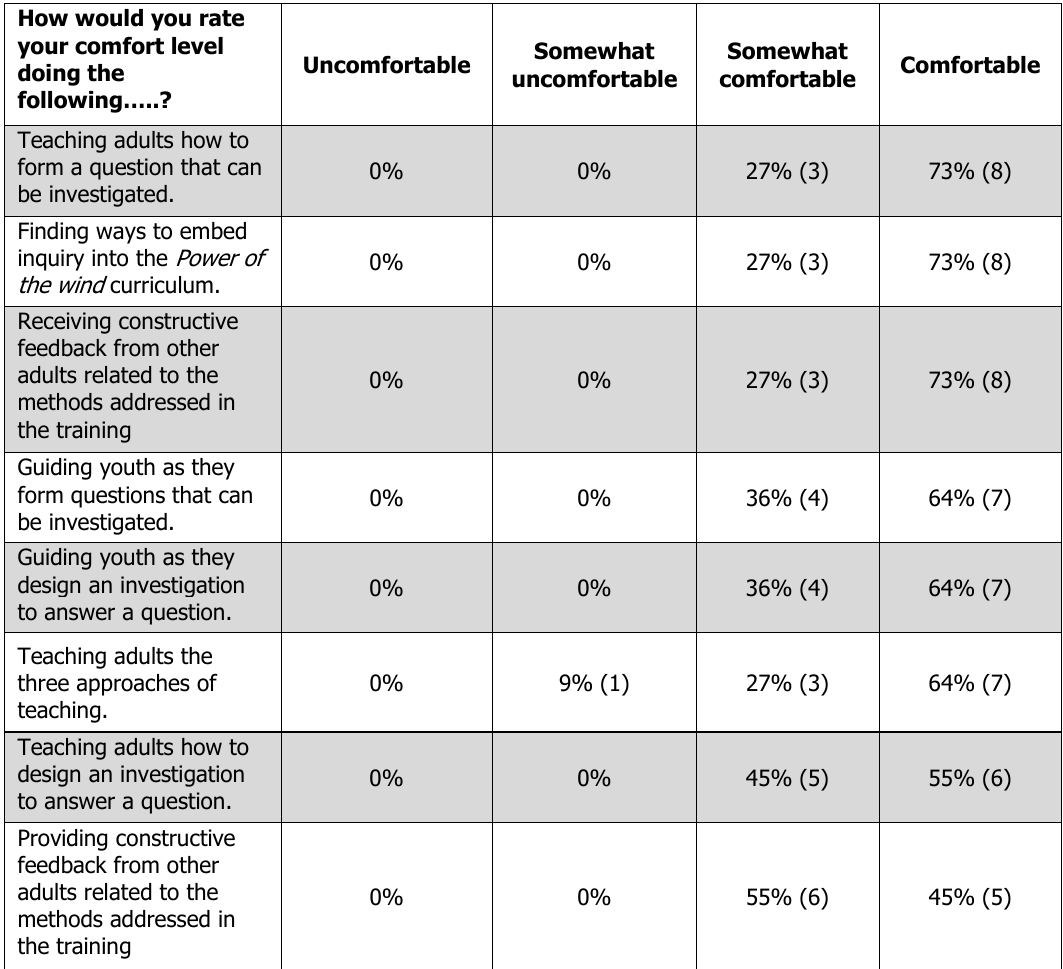
Lead Trainer Self-Assessments